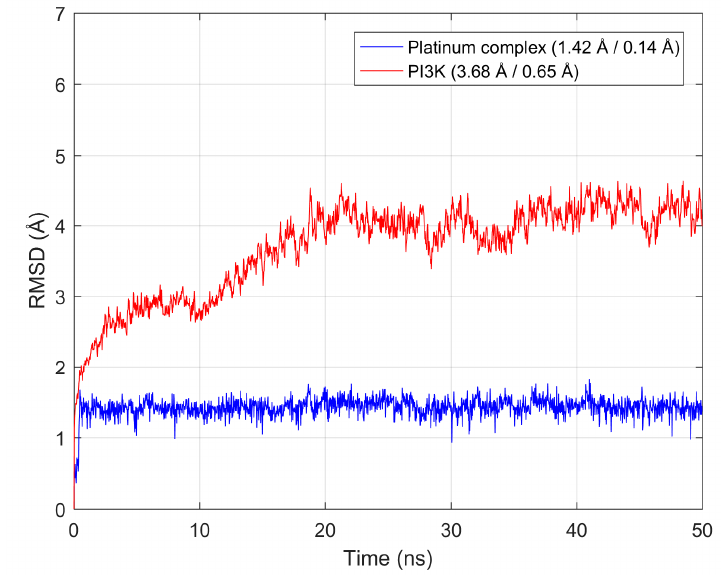
Figure 4. RMSD vs. Time. The behavior of PC is shown in blue and, in red, the evolution over time of the PI3K.